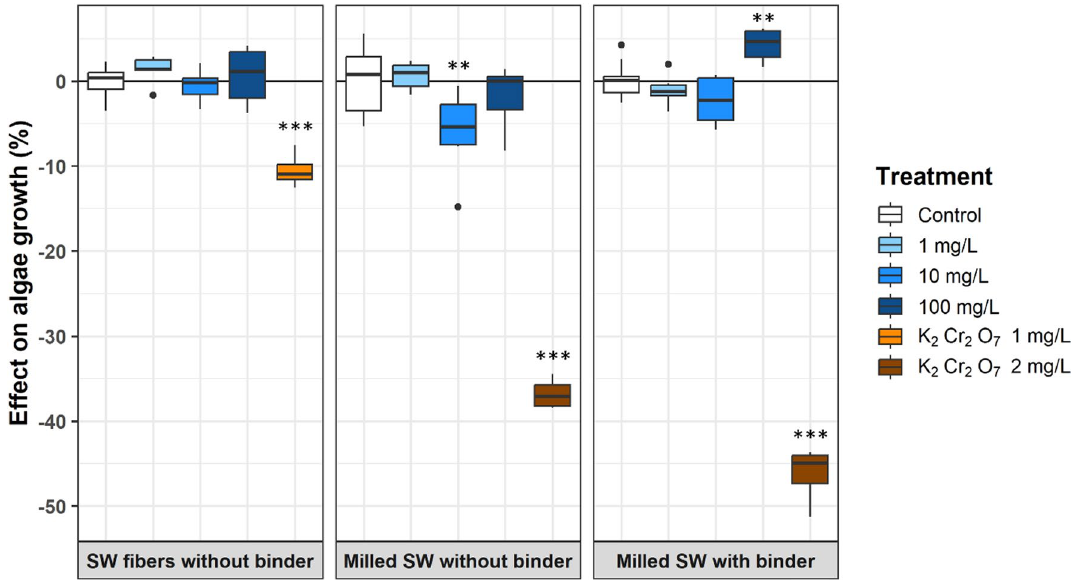
Fig. 4 Results of the algae growth inhibition test for the negative control (white), the eluates of three concentrations (1, 10 and 100 mg/L) of each of the three test materials (blue colors) and the positive control (potassium dichromate; orange colors) as boxplots. Boxes depict the lower and upper quartile as well as the median; whiskers show the standard deviation of mean of n 6 replicates and dots represent outliers. Effects were = calculated in comparison to the mean value of algae growth in the negative control and positive effect values show algae growth stimulation, while negative values show growth inhibition. Asterisks denote significant differences between the treatments and the negative control (Dunnett’s test: *: p < 0.05, **: p < 0.01, ***: p <